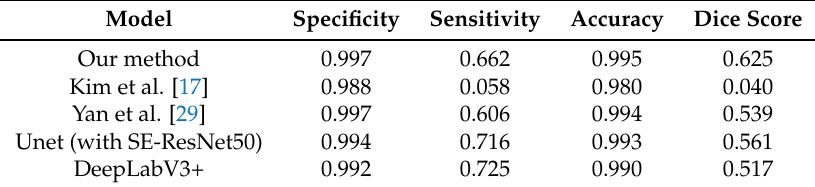
Table 3. The comparison of drusen segmentation methods on Kangbuk Samsung Hospital dataset.